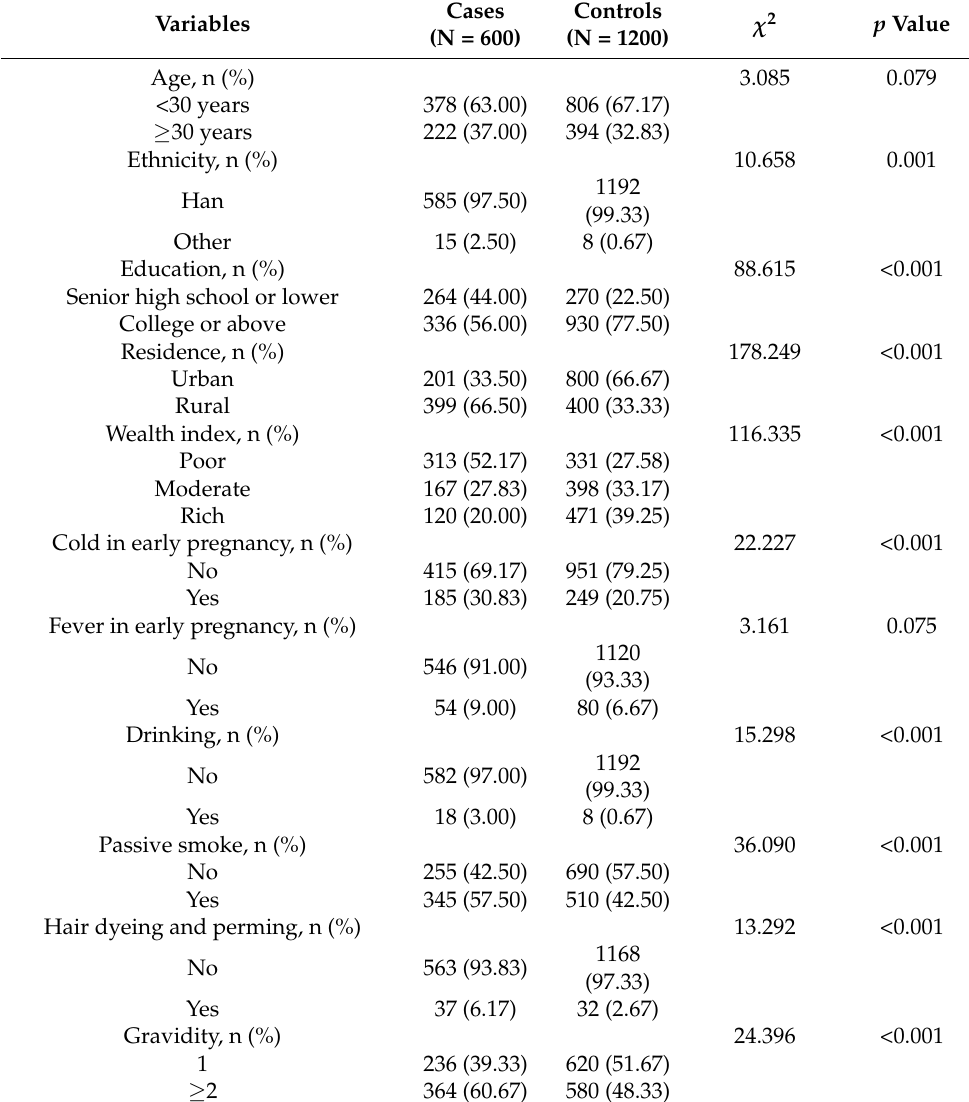
Table 1. Characteristics of participants in the case group and the control